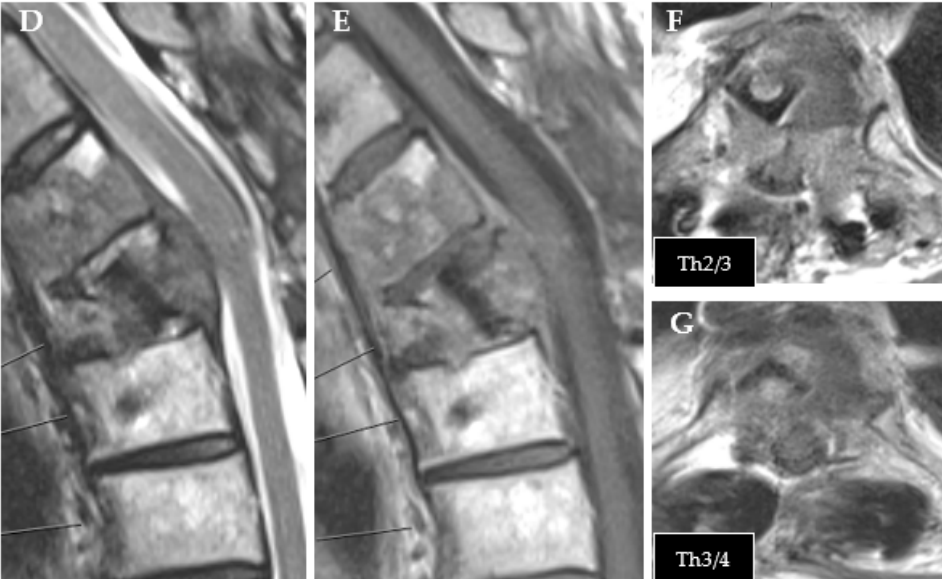
Figure 1. Exemplary case of tumor recurrence. ( A – C ): preoperative MRI of thoracic metastasis from urothelial carcinoma (T1 contrast enhanced). ( D – G ): follow-up MRI after CFR-PEEK instrumentation showing tumor recurrence (( D ): T2; ( E – G ): T1 contrast enhanced).